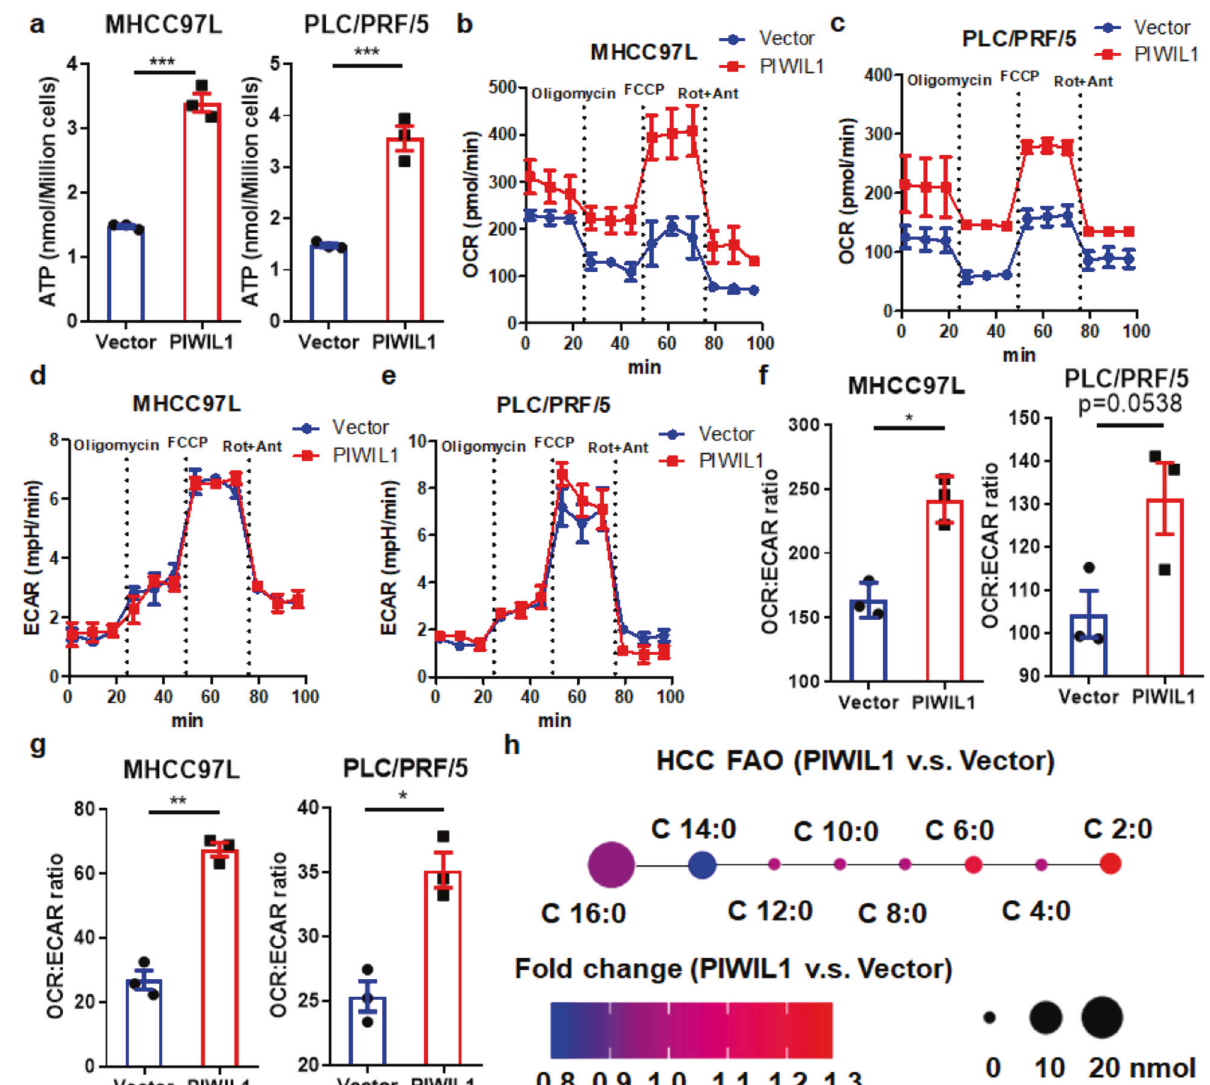
Fig. 2 PIWIL1 modulates fatty acid oxidation in HCC cells. a Intracellular ATP of PIWIL1-overexpressing HCC cells was signi fi cantly higher than that of wild-type cells; Overexpression of PIWIL1 could signi fi cantly increase the oxygen consumption rate of HCC cells, as indicated by OCR assay ( b , c ), while its effect on ECAR of HCC cells was not signi fi cance ( d , e ). Overexpression of PIWIL1 led to the higher value of OCR/ECAR ratio at basal ( f ) and maximal ( g ) respiration. h The composition of fatty acid metabolites of wild type and PIWIL1-overexpressing HCC tumors was analyzed by GC-MS, which indicated an increase of C16 intermediates ( n = 5). All experiments were performed in triplicate if without particular notice. * p < 0.05; ** p < 0.01; *** p <